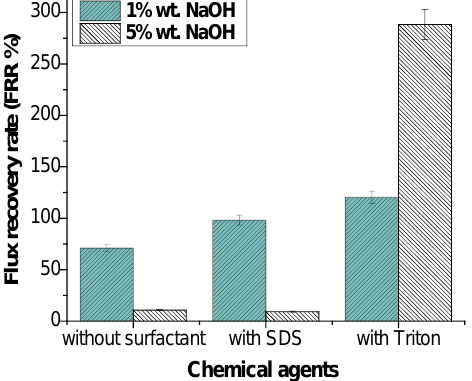
Figure 5. Effect of chemical agents on flux recovery by alkaline cleaning.